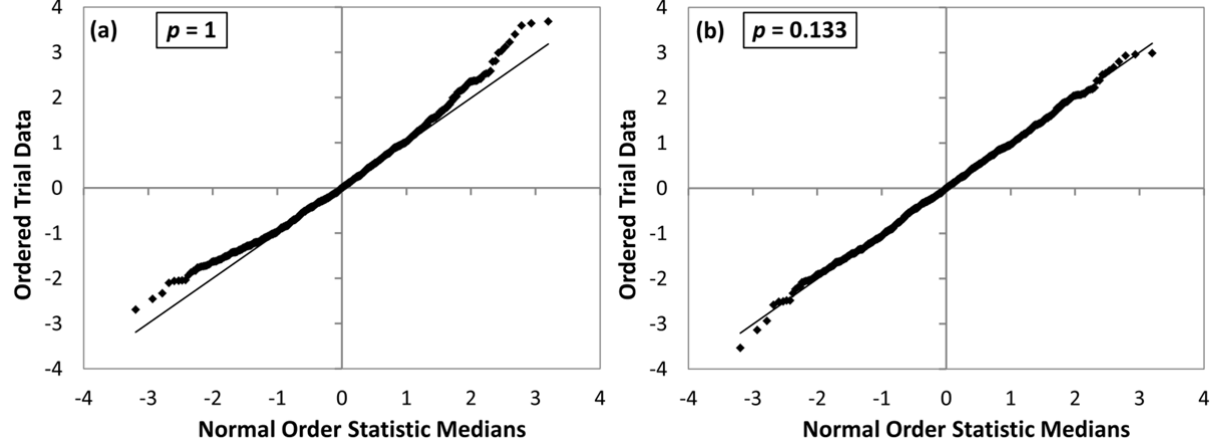
Figure 4. Examples of normal probability plots for one transition (see text). ( a ) The plot with no transformation of A values ( p = 1) shows departure of the statistics from the normal distribution; ( b ) The plot with the optimal Box–Cox transformation parameter ( p = 0.133) shows that the statistics are close to normal.